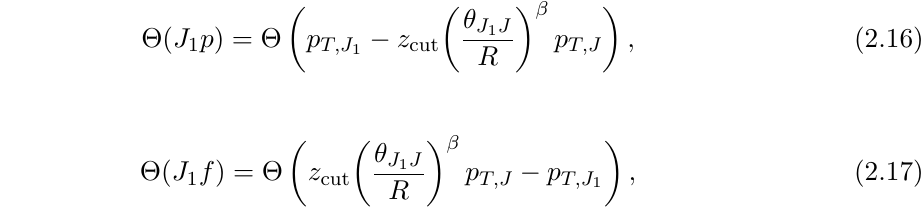
Figure 1 . Con(cid:12)gurations that give rise to di(cid:11)erent NGL contributions at NNLO (left) and (cid:11) 2 ln 2 ( z cut (cid:18) (cid:12) ) (right). The inner ellipse denotes the area set by the groomed radius R g s g (cid:24) inside the original ungroomed